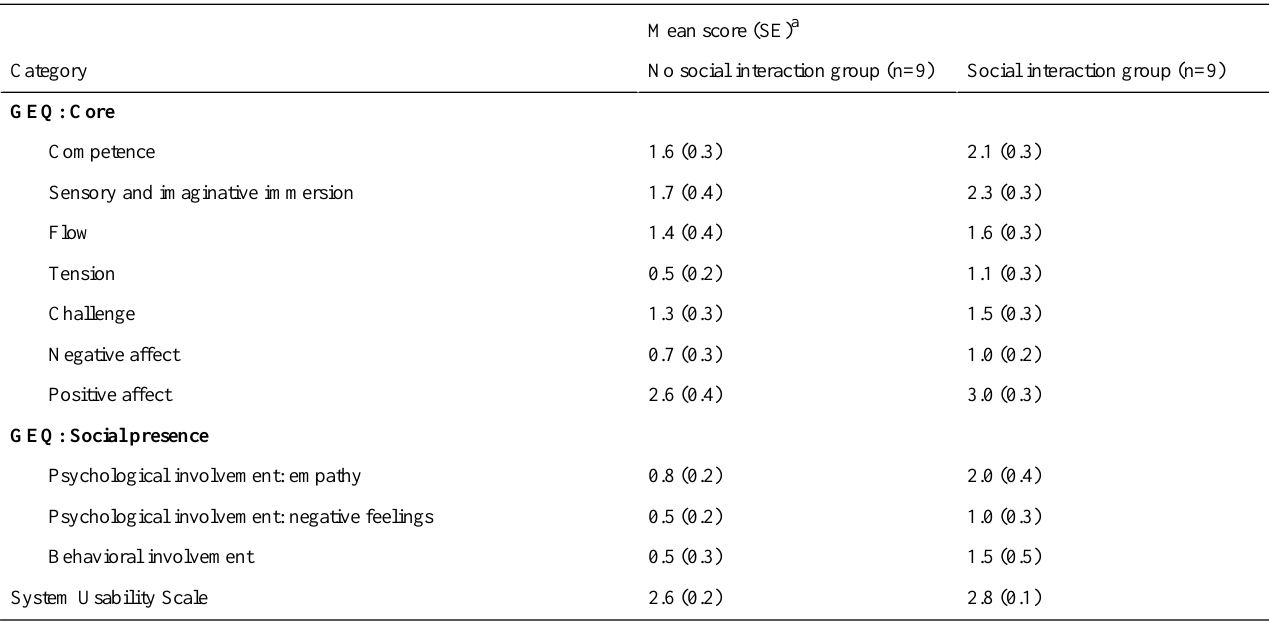
Table 3. Mean scores for Game Experience Questionnaire (GEQ) and System Usability Scale